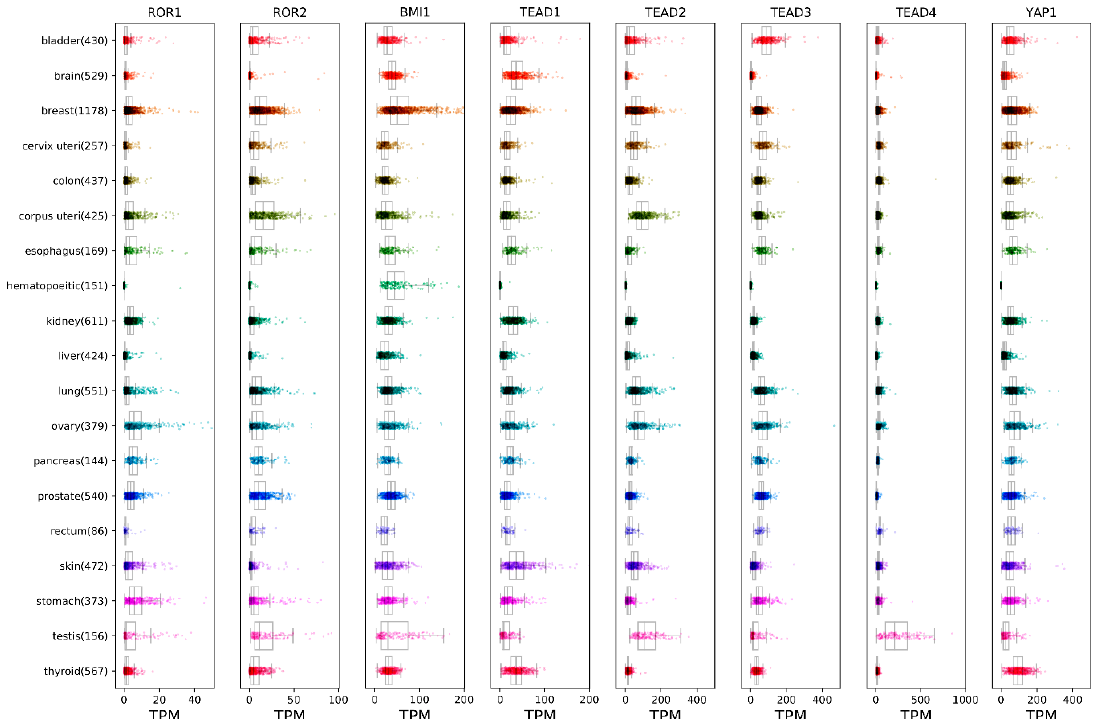
Figure 1. Expression analysis of receptor tyrosine kinase-like orphan receptor 1 (ROR1), ROR2, BMI-1 and YAP/TAZ genes in various human cancers. RNA-Seq expression data was obtained from The Cancer Genome Atlas (TCGA) Research Network data portal (https://portal.gdc.cancer.gov/). Fragments per kilobase million (FPKM) expression values were extracted for all target genes using custom Python scripts and converted to transcripts per million (TPM), and finally visualized as boxplots utilizing the Matplotlib [27] and Seaborn [28] plotting libraries.